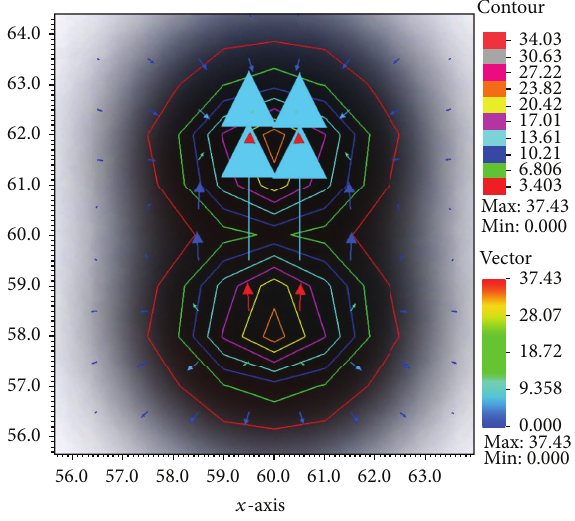
Figure 1: A 2-dimensional plot (jet cross-section, depicting a slice cut parallel to the 𝑥𝑧 -plane) of the strongest components of the jet magnetic field, in PLUTO simulation units. We can see that the toroidal component (ringwise) constitutes a significant part of the field, while other magnetic lines form part of the poloidal component, especially near the jet axis.